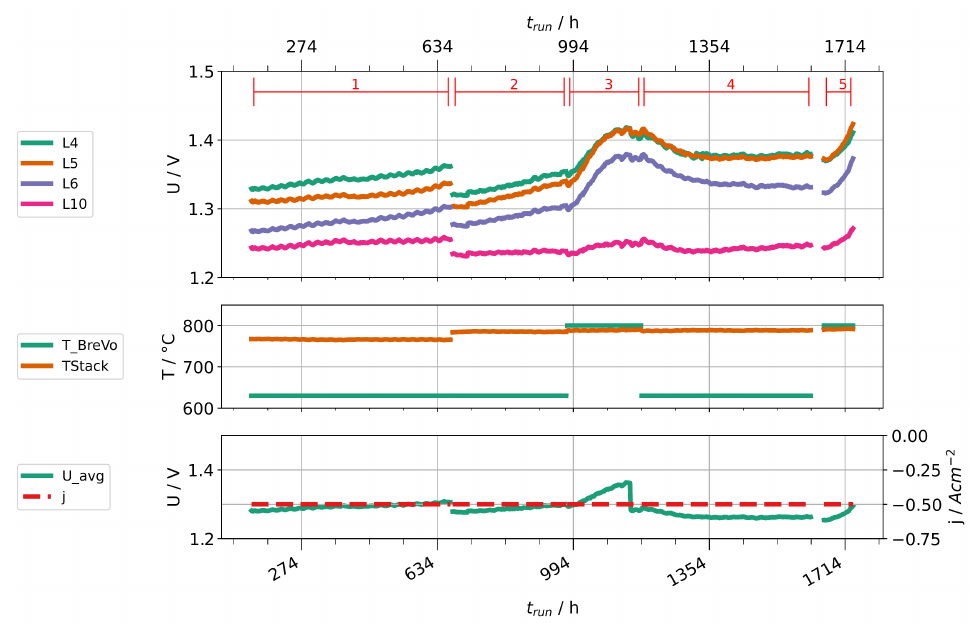
Figure 14. Time traces showing layer voltages, current densities, stack temperatures, and preheater operation temperatures for stack A.